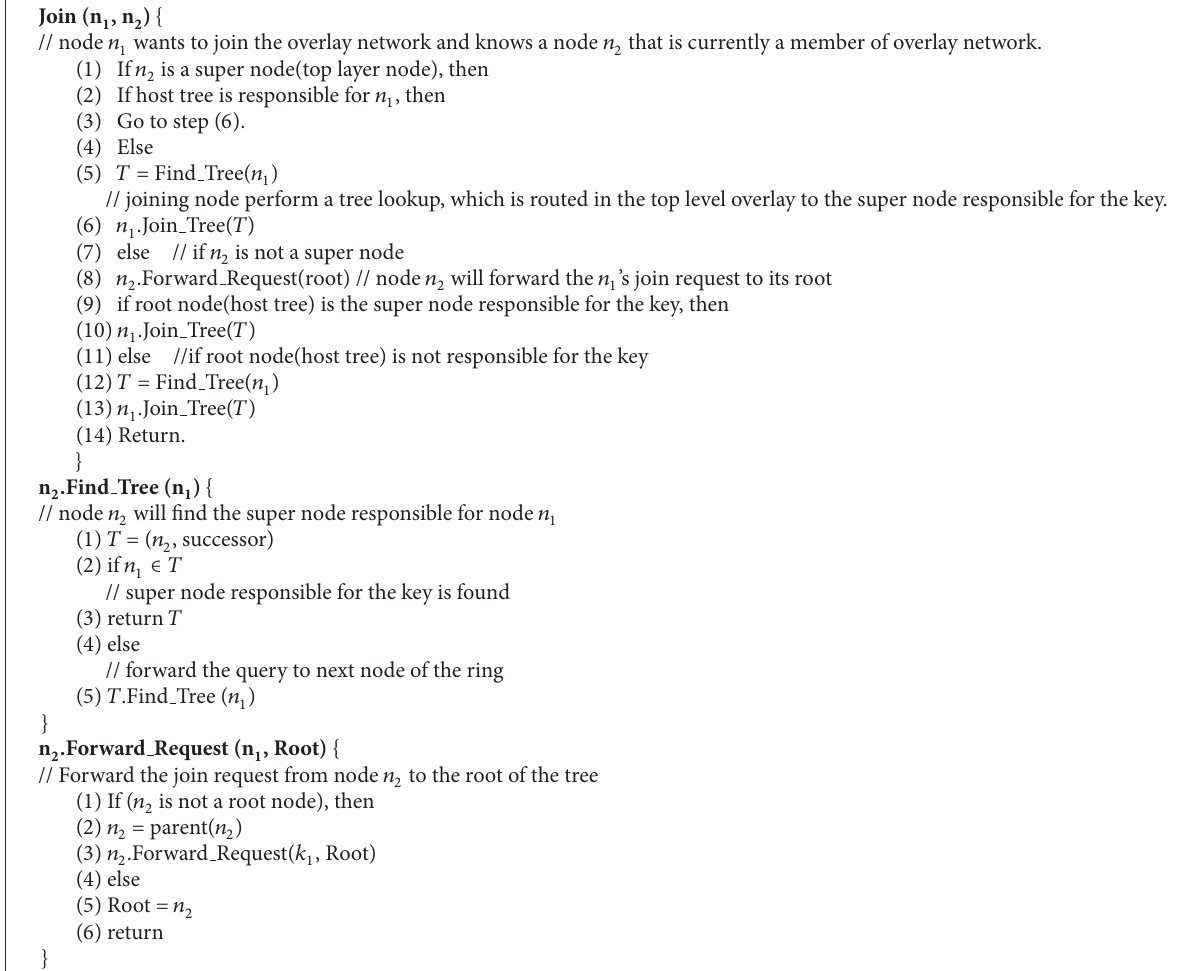
Algorithm 2: Peer join operation in proposed